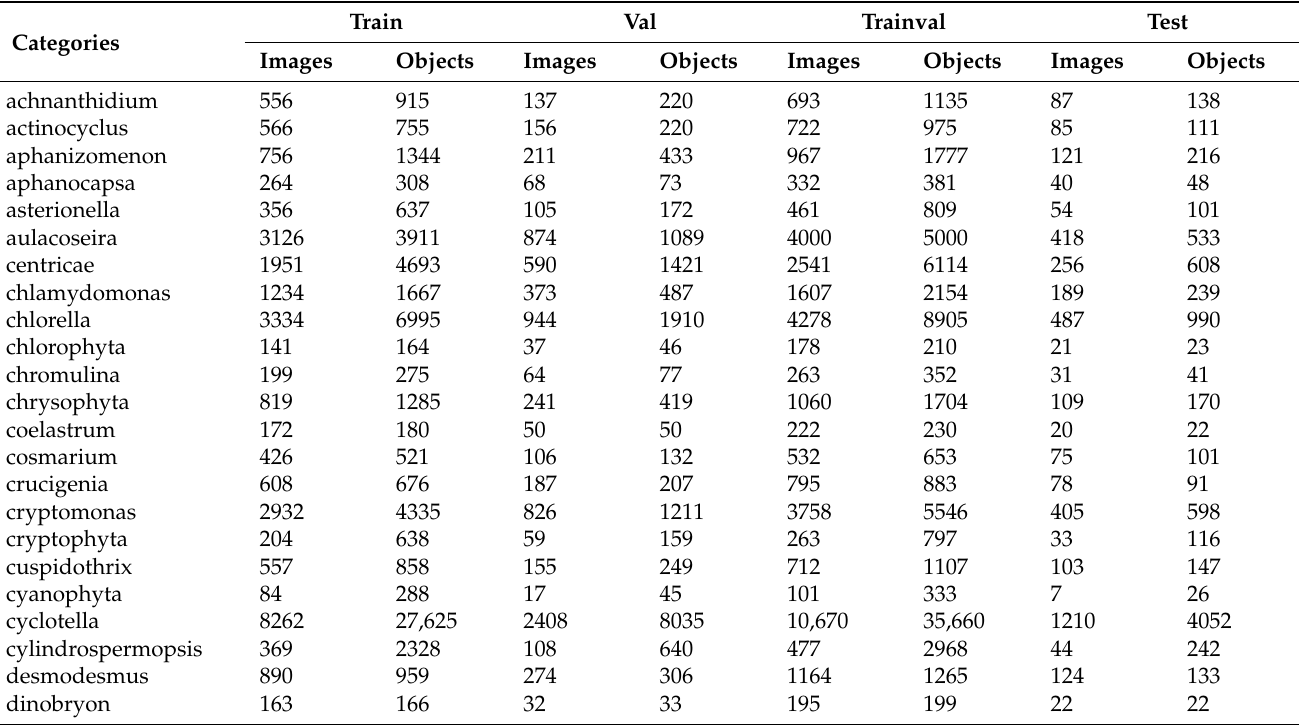
Table 1. Statistics of the algal detection